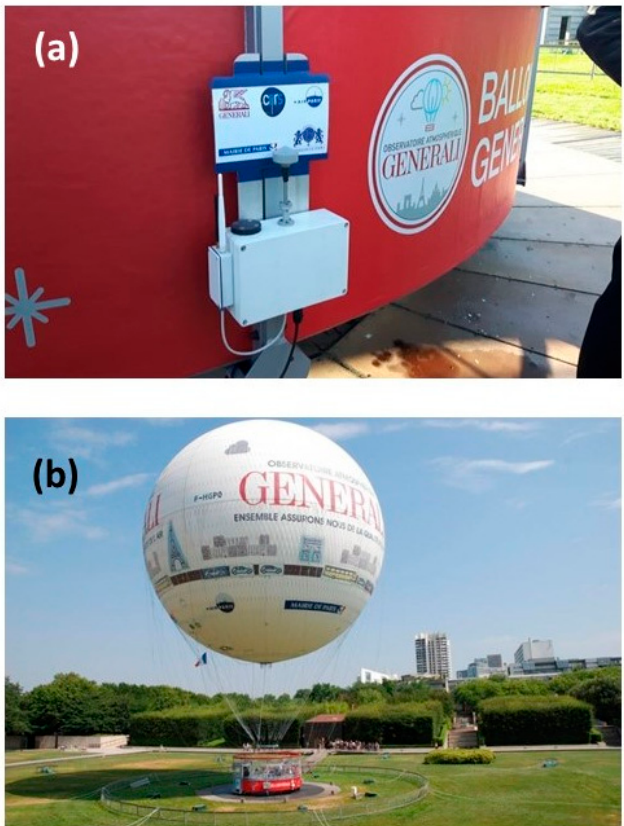
Figure 2. ( a ) LOAC mounted on the gondola of the “Ballon de Paris Generali”; ( b ) The balloon in the park André Citroën (Paris, France).